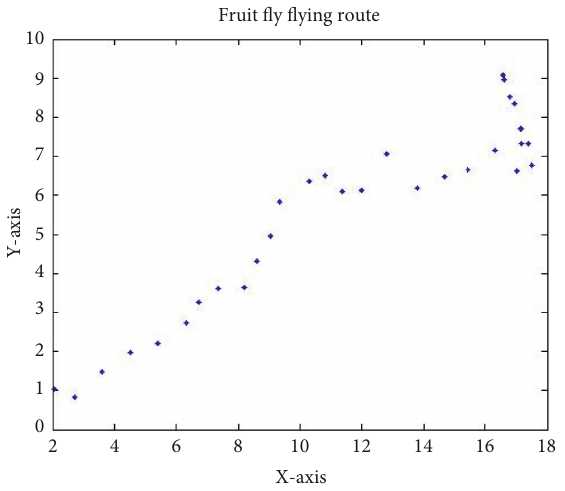
Figure 7: FOA-GRNN fruit fly search path.